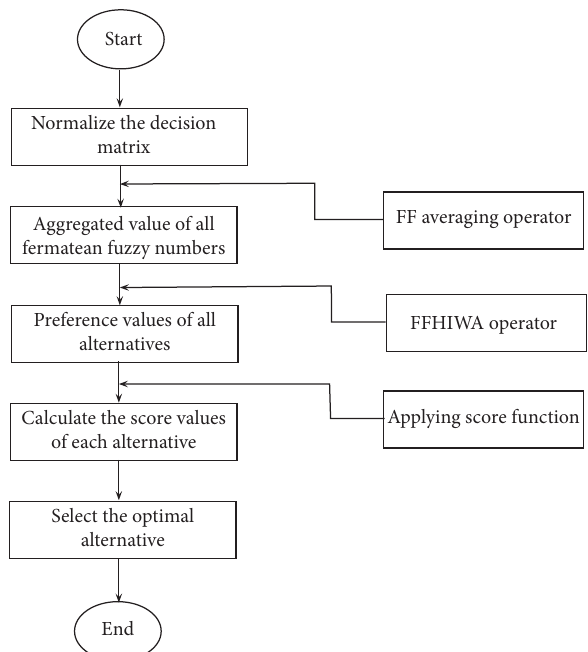
Figure 1: Flow chart for the classification of the air quality of